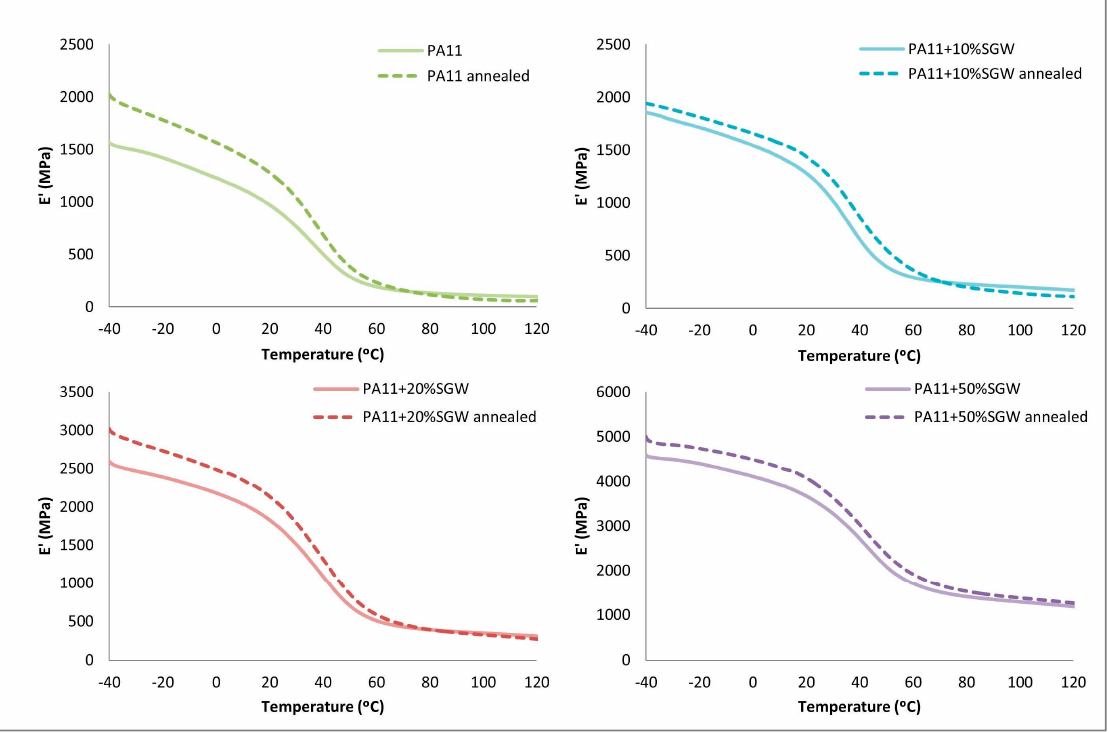
Figure 10. Storage modulus of treated and untreated samples obtained by DMTA.